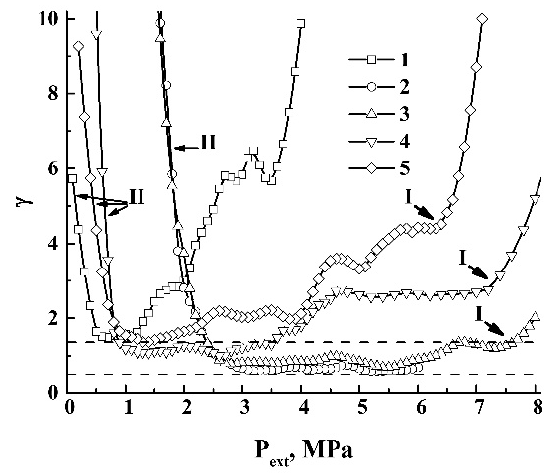
Figure 11. Theoretical values of the pressure-dependent instantaneous polytropic index for the adiabatically expanding carbon dioxide. T = 309.15 K. P s = : 1–15.0 MPa; 2–10.0 MPa; 3–7.5 MPa; 4–5.0 MPa; 5–1.0 MPa.